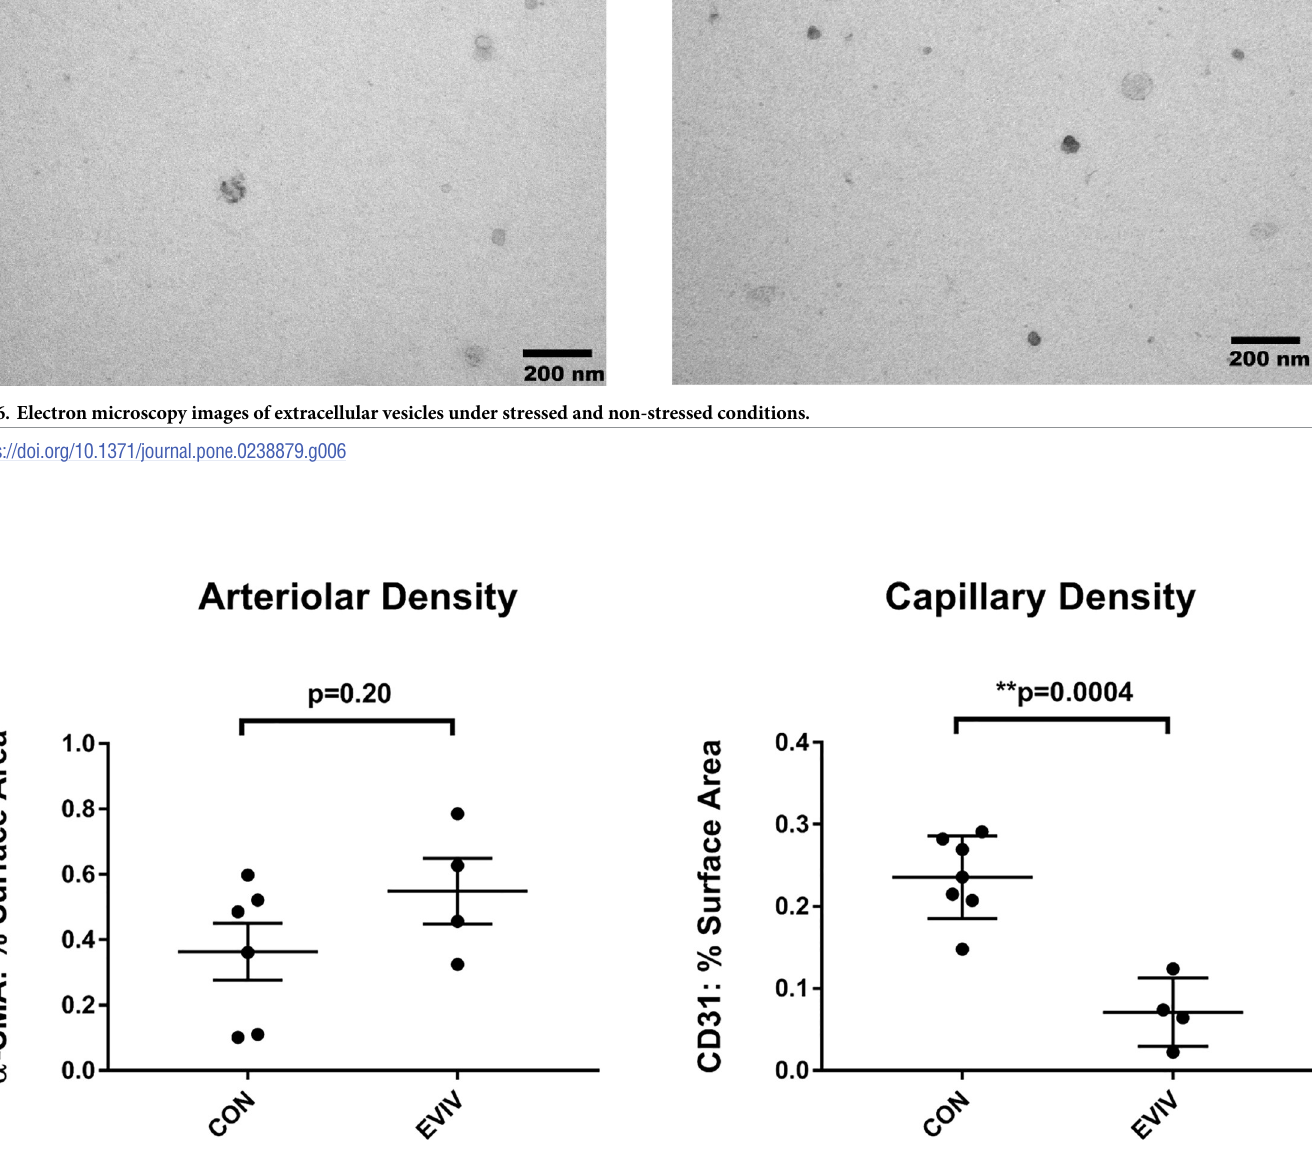
PLOS ONE | https://doi.org/10.1371/journal.pone.0238879 September 11,